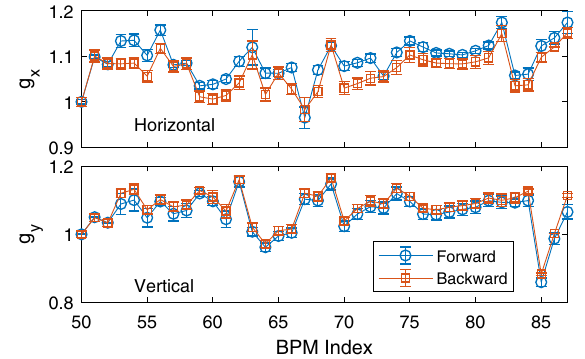
FIG. 14. Fitted BPM gains for the BSY and LTU BPMs using fitting with forward or backward tracking. Top: horizontal; Bottom: vertical. Gains for BPM #50 are set to